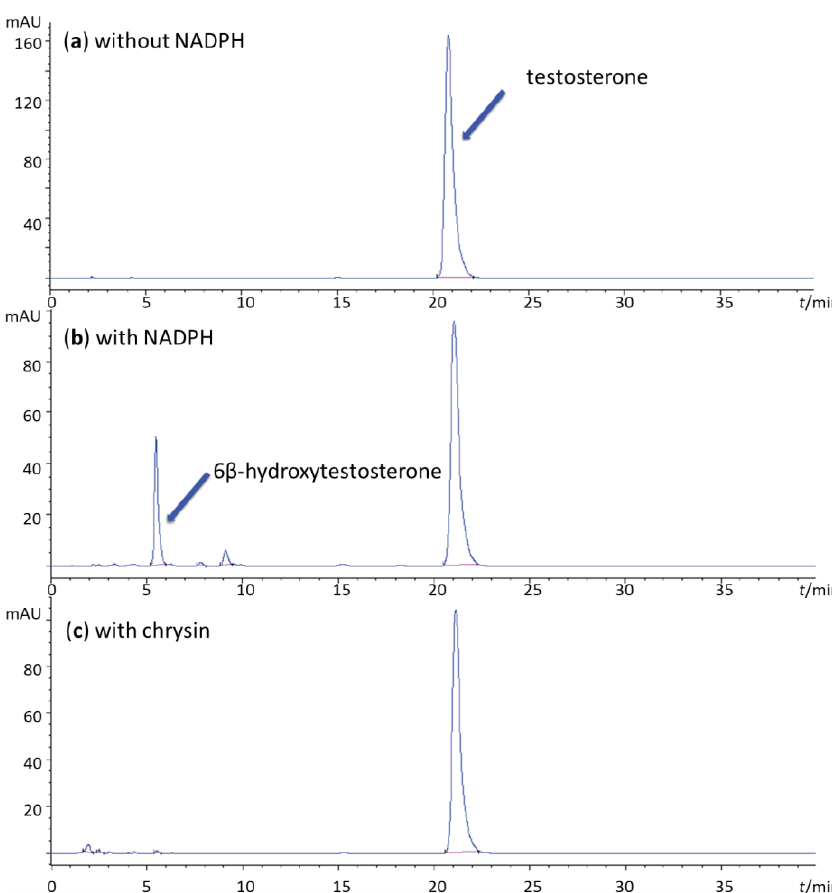
Figure 1. Chromatogram of testosterone oxidation by recombinant baculovirus system with hyper expressed CYP3A4, monitored at 240 nm. ( a ) Incubation without the NADPH-generating system. The testosterone substrate is shown at t R = 20.7 min. ( b ) Incubation with the NADPH generating system, showing the metabolite, 6 β -hydroxytestosterone, at t R = 5.4 min. ( c ) Incubation with the NADPH-generating system and flavonoid (chrysin). Significant inhibition of the CYP3A4 activity is observed as the production of the major testosterone metabolite is significantly lower ( t R = 5.4 min).